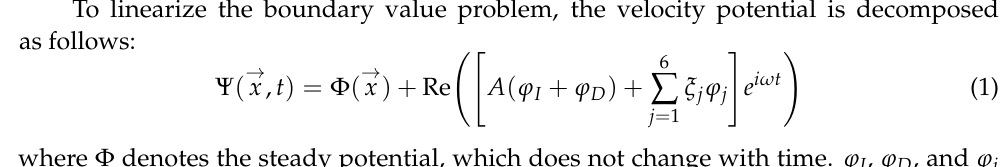
Figure 6. Coordinate system ( a ) and examples of panel model ( b ) for numerical method.